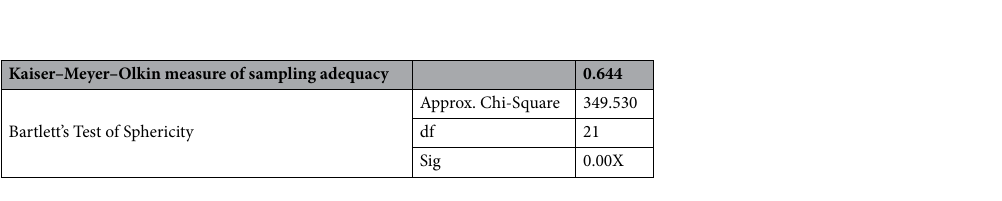
Table 4. Kaiser–Meyer–Olkin (KMO) and Bartlett’s